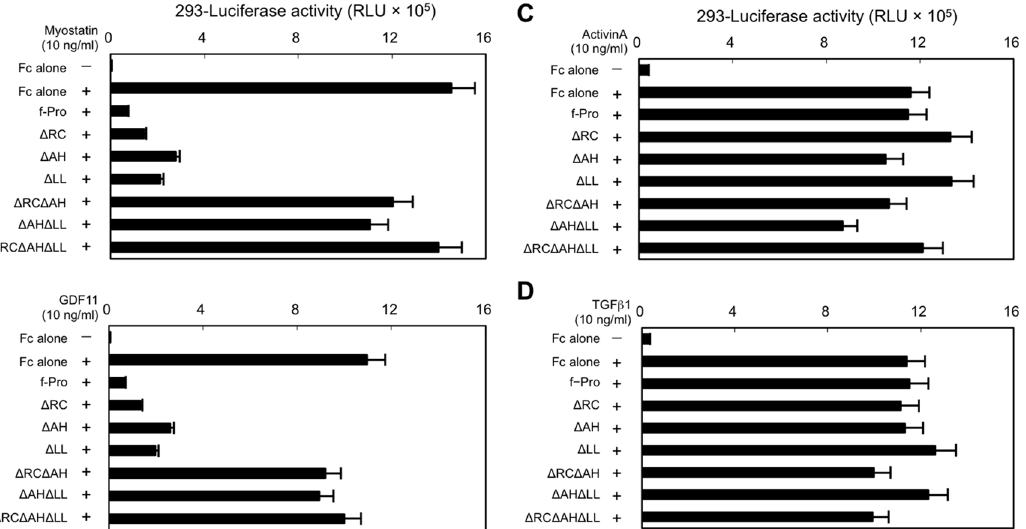
Fig 4. Three consecutive regions within the inhibitory core exhibit coordinated suppression of myostatin activity. Constructs ( Δ RC, Δ AH, and Δ LL) with single deletions of the RC, AH, or LL regions of full-length myostatin (f-Pro) showed an inhibitory effect on the transcriptional activities of myostatin ( A ) and GDF11 ( B ), but not activin A ( C ) or TGF- β 1 ( D ), in HEK293 cells. In contrast, combined deletion constructs ( Δ RC Δ AH, Δ AH Δ LL, and Δ RC Δ AH Δ LL) had no inhibitory effect on myostatin ( A ) or GDF11 ( B ) activation in the HEK293-(CAGA) 12 -luciferase